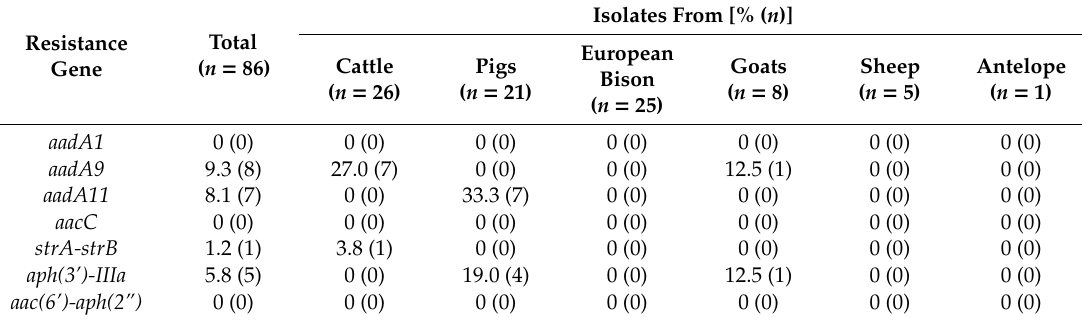
Table 3. Distribution of the aminoglycoside resistance genes in studied Trueperella pyogenes isolates ( n = 86).